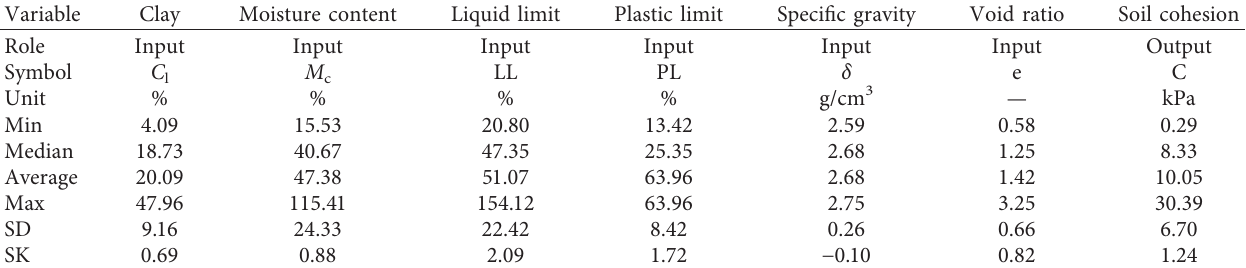
Table 1: Initial statistical analysis of the